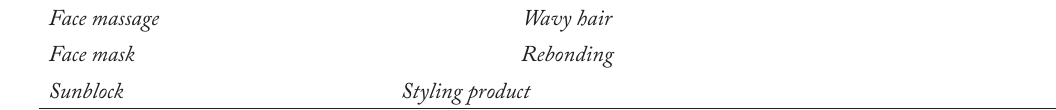
Table 3. Beauty and Personal Care Products Categories in Pakistan Classification by Allied Market Classification by Euromonitor Classification by Market Research Research Makeup/color cosmetics Baby and child-specific products Eye make-up products Haircare products Bath and shower Lip make-up products Deodorants Color cosmetics Make-up and skincare powders Skin and sun care products Deodorants Pedicure and manicure products Fragrances Depilatories Other make-up and skincare